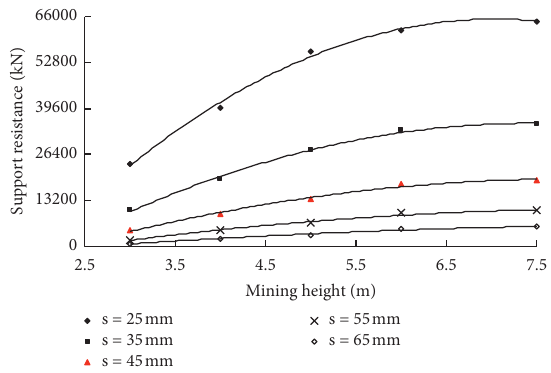
Figure 10: Variation curves of initial supporting force and mining height after assigning subsidence. Table 3: Regression equations and correlation of subsidence along with mining height and initial supporting